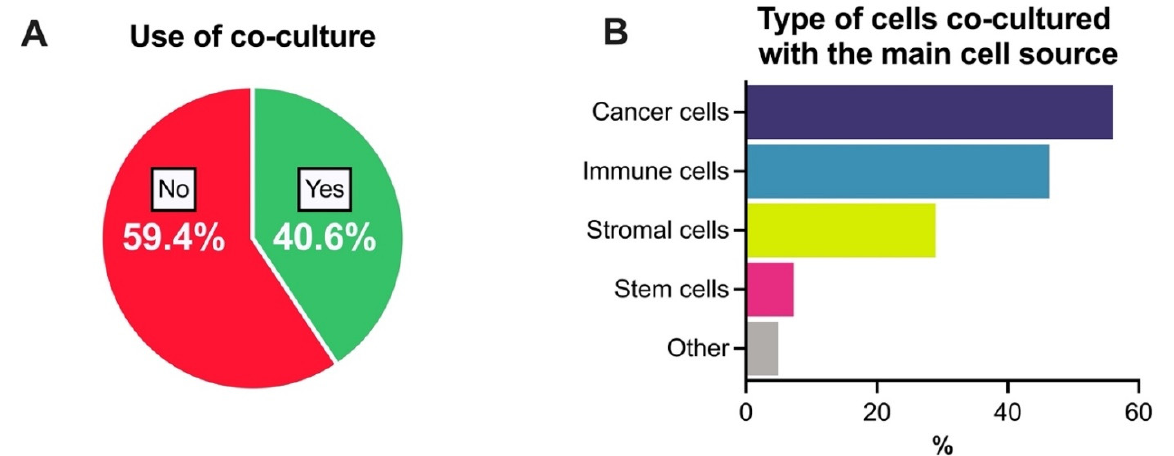
Figure 3. Co-culture use in pre-clinical in vitro tumor models. ( A ) Use of co-culture models and ( B ) types of cells used in these co-culture models together with the main cell source. Results are represented as percentages (%). Note: Figure 3B represents a question with multiple choice. Some respondents indicate that their co-culture models involved more than one type of cell.